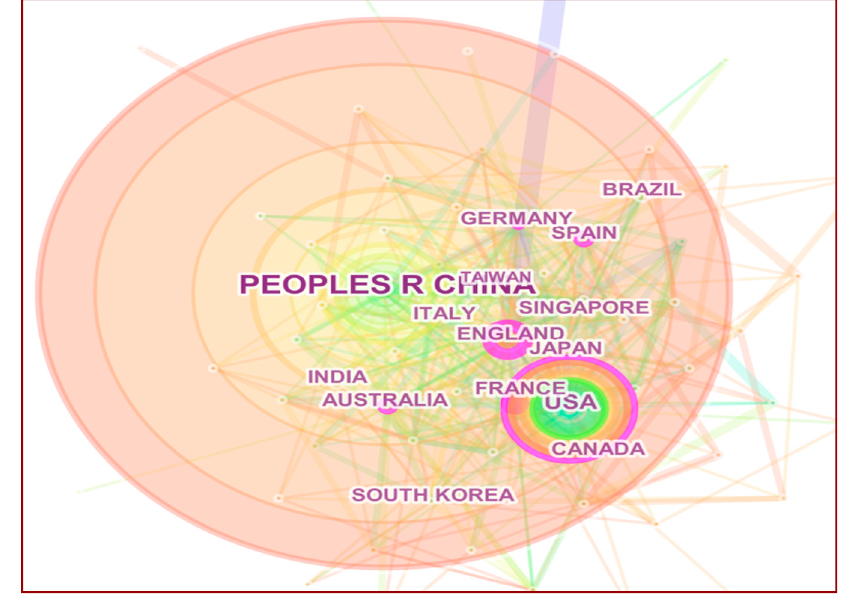
Figure 5. Countries Co-Citation Analysis.